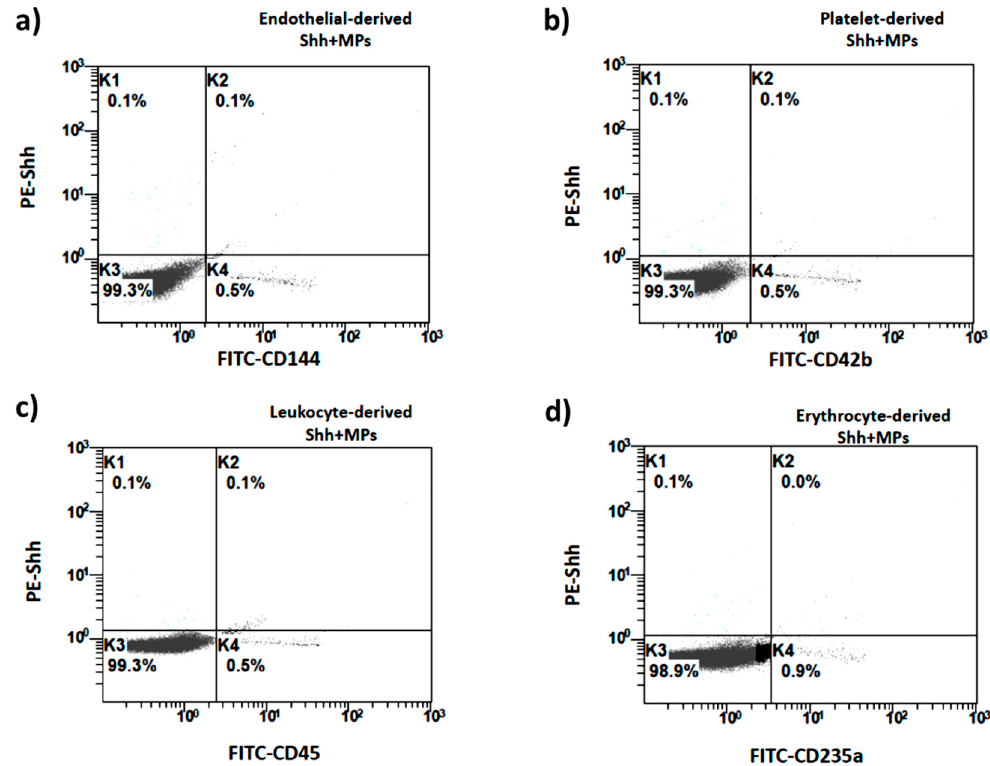
Figure 8. Size-selected events are plotted according to their fluorescence for specific CD144, CD42b, CD45, CD235a, and Shh binding. Events included in the K4 section were considered Shh + EMPs ( a ), Shh + PMPs ( b ), Shh + LMPs ( c ), and Shh + ErMPs ( d ).